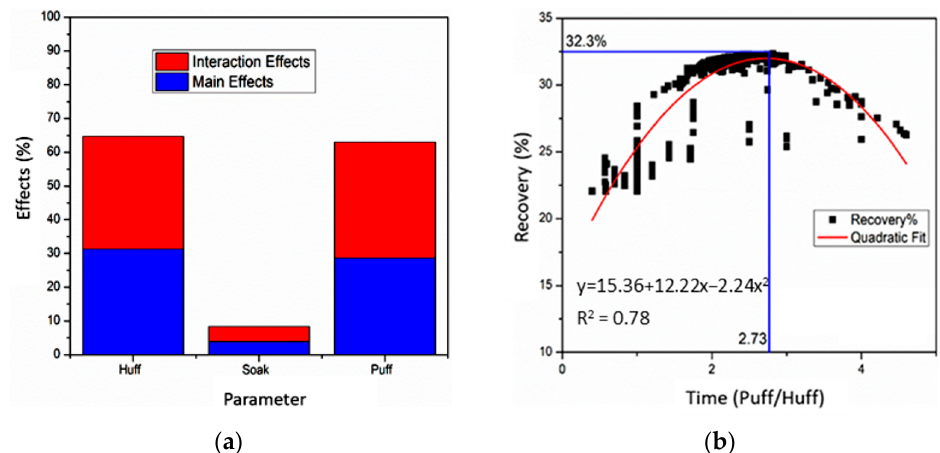
Figure 9. ( a ) Effects between primary parameters; ( b ) quadratic fit model of recovery vs. HnP.